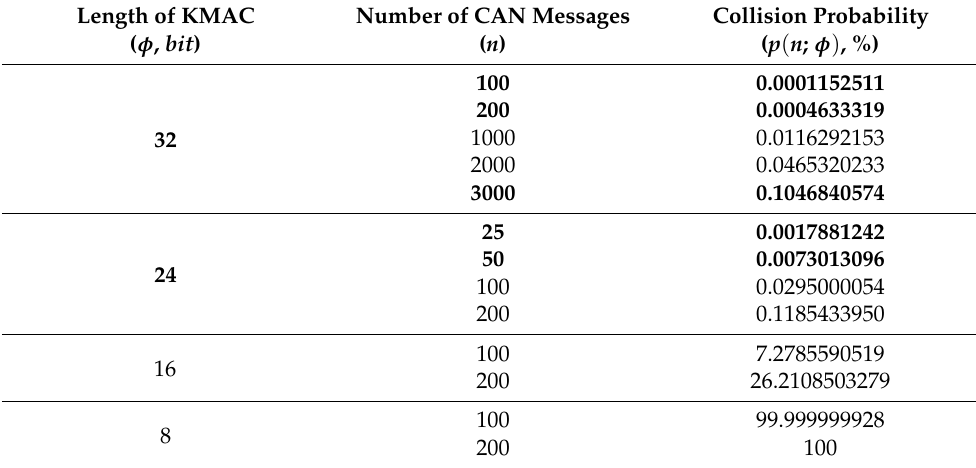
Table 2. Probability of success of a cyber-attack as a function of the length of